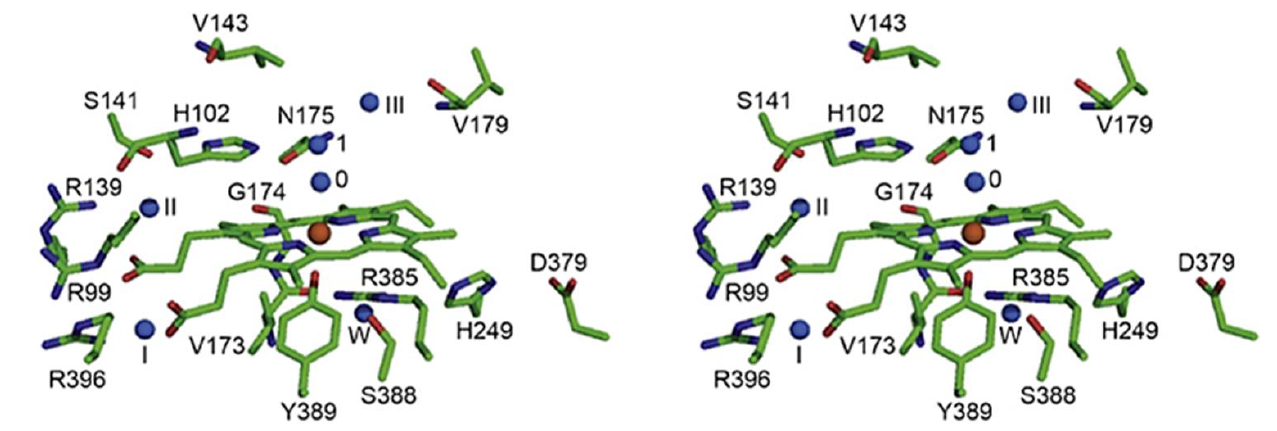
Figure 3. Stereo view of the CAT-3 active site. Shown are the propionic acids of the heme that make salt bridges with three conserved Arg residues and the conserved amino acid residues in the proximal and distal side of the heme. Water molecules are shown in blue. Reprinted with permission from ref. [11] 2009, Elsevier.